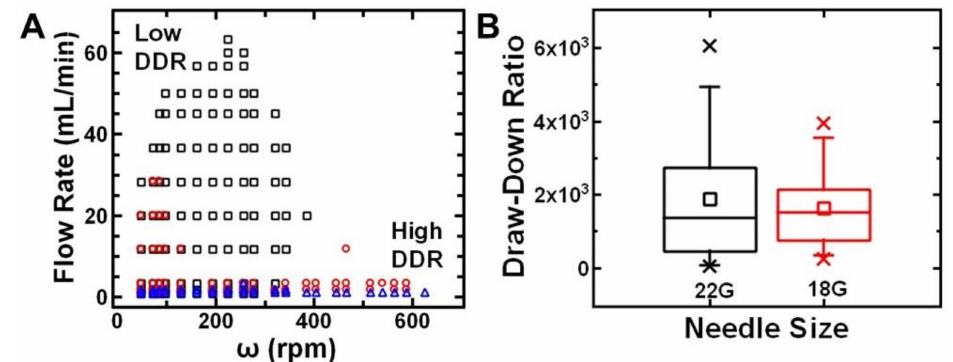
Figure 3. ( A ) Map of spinnability of 30 wt.% polystyrene solutions at varying flow rates and collector speeds for 7:3 v : v toluene to acetone (black squares), 8:2 v : v toluene to acetone (red circles), and toluene (blue triangle) ( B ) Box plot of draw-down ratio ranges for 30 wt.% polystyrene in 8:2 v : v toluene to acetone. Draw-down ratios of ~2000 are appropriate for continuous processing of polystyrene